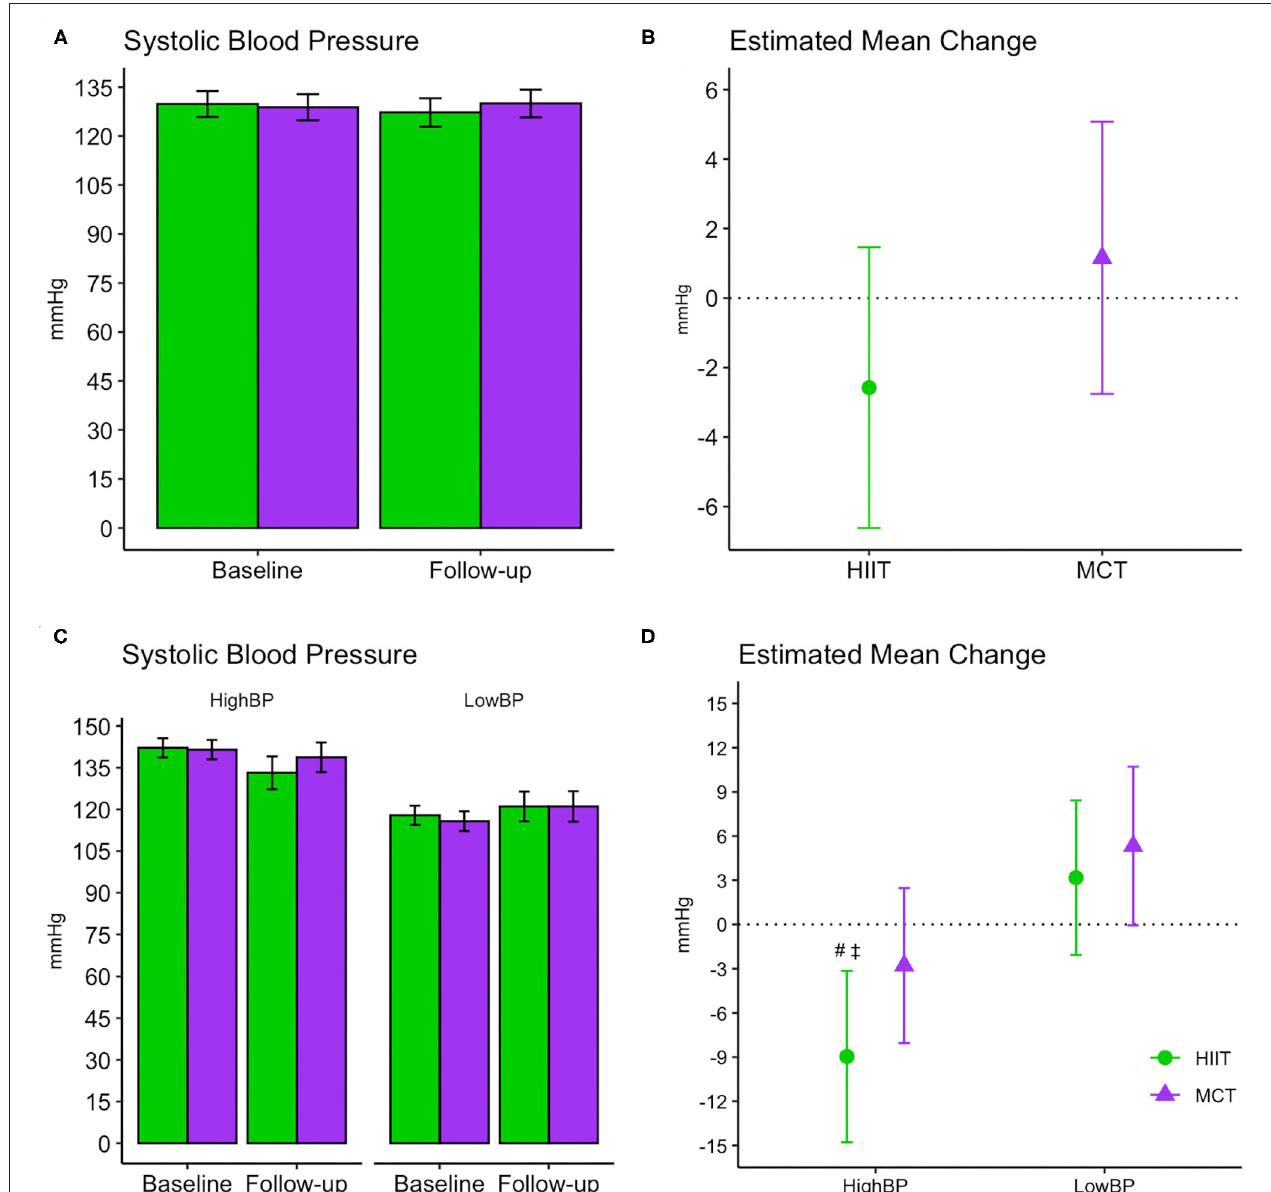
FIGURE 6 | Baseline and follow-up means for systolic blood pressure readings ( A,C , group mean and 95% CI) and estimated mean change from baseline to 6 months ( B,D , estimated mean change and 95% CI). (A,B) Display changes for the entire sample, while (C,D) display changes within subgroups stratified by baseline systolic blood pressure readings. #, significant changes over time at adjusted significance threshold ( p ≤ 0.005); See Supplementary Table 2 for further details. ‡, greater changes compared to HIIT Low BP [difference between groups (CI): − 12.14 mmHg ( − 19.98 to − 4.30), p = 0.003] and MCT Low BP [ − 14.28 mmHg ( − 22.22 to − 6.35), p = 0.001] at adjusted significance threshold ( p ≤ 0.005). CI, confidence interval; HIIT, high-intensity interval training; MCT, moderate-intensity continuous training; High BP, high systolic blood pressure at baseline; Low BP, low systolic blood pressure at